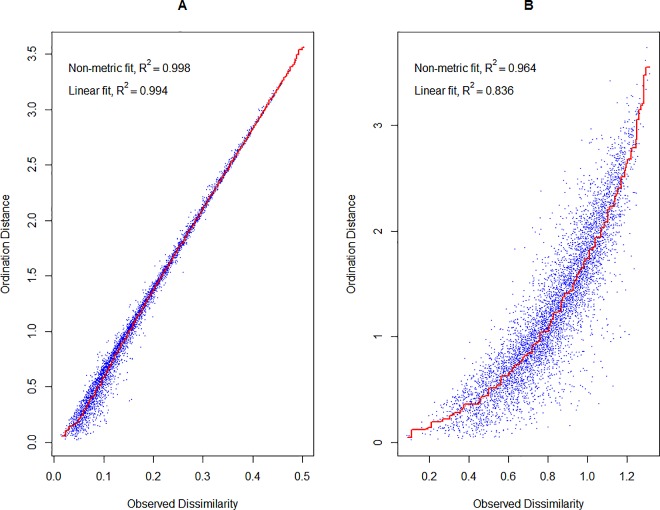
Shepard diagrams of the NMDS results.(A) physicochemical data (normalized) and (B) melissopalynological data (normalized). Dashed line signifies a perfect linear relationship between calculated and ordination distances.